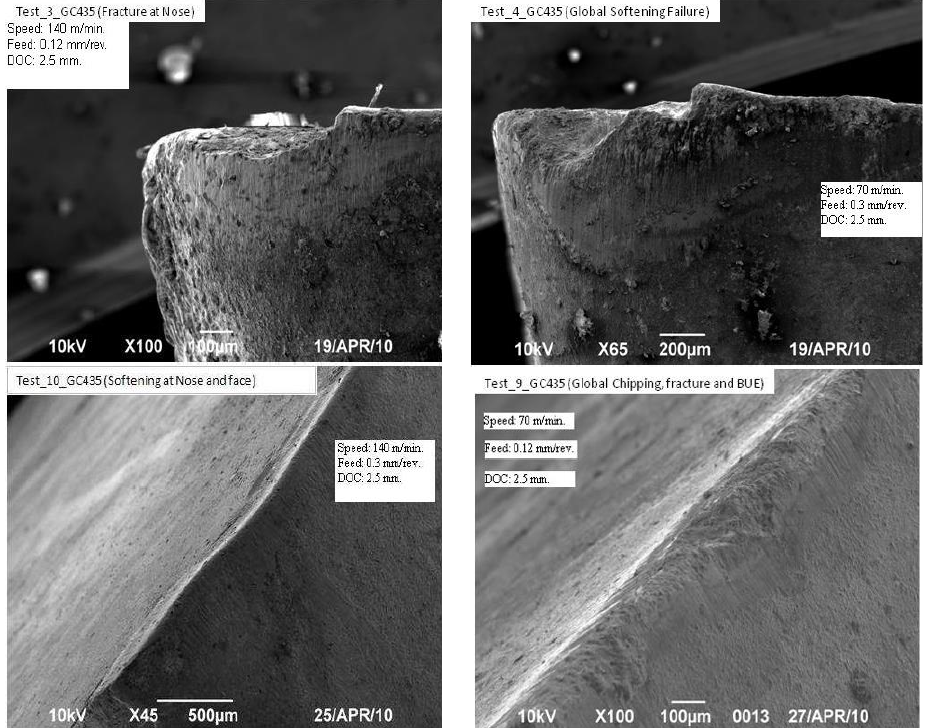
Table 2. The experimental data.